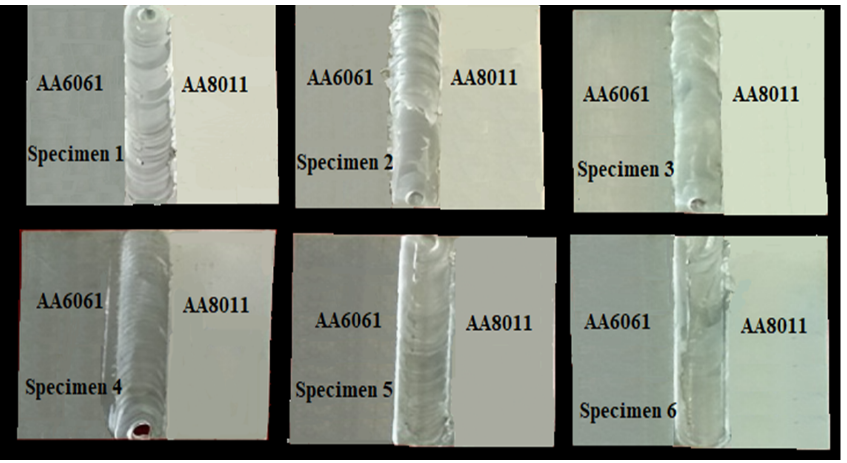
Figure 2. Dissimilar specimens after welding.